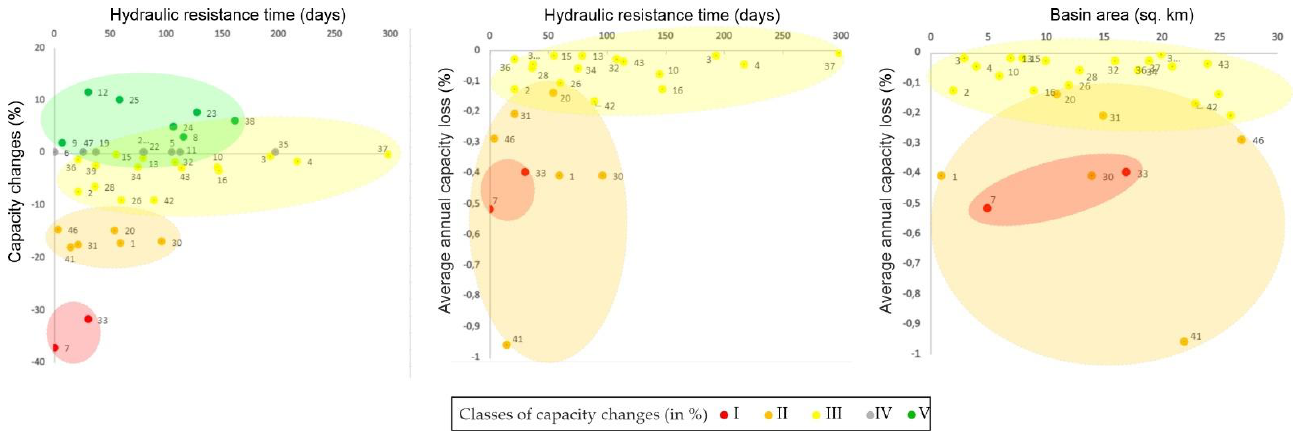
Figure 6. Statistical significance between calculated indicators of reservoir’s capacity changes and the selected characteristic features of reservoirs.